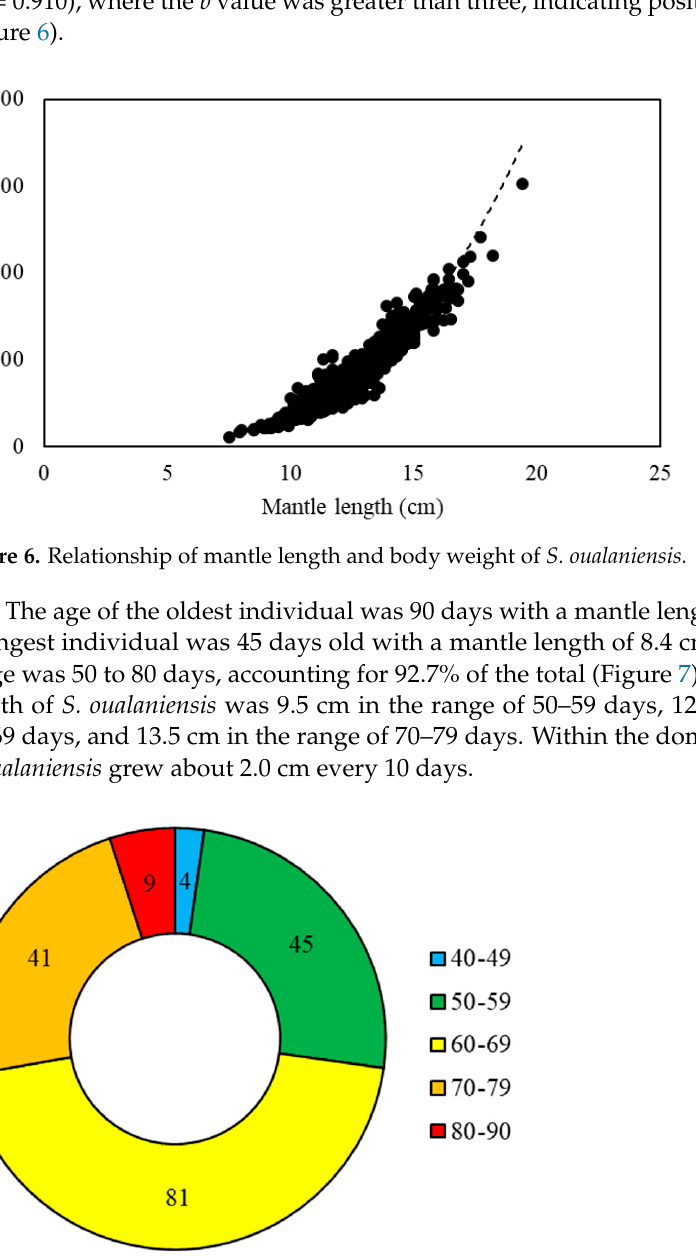
Table 2. Model equation parameters for S. oualaniensis. Bold means the parameters of the best model.